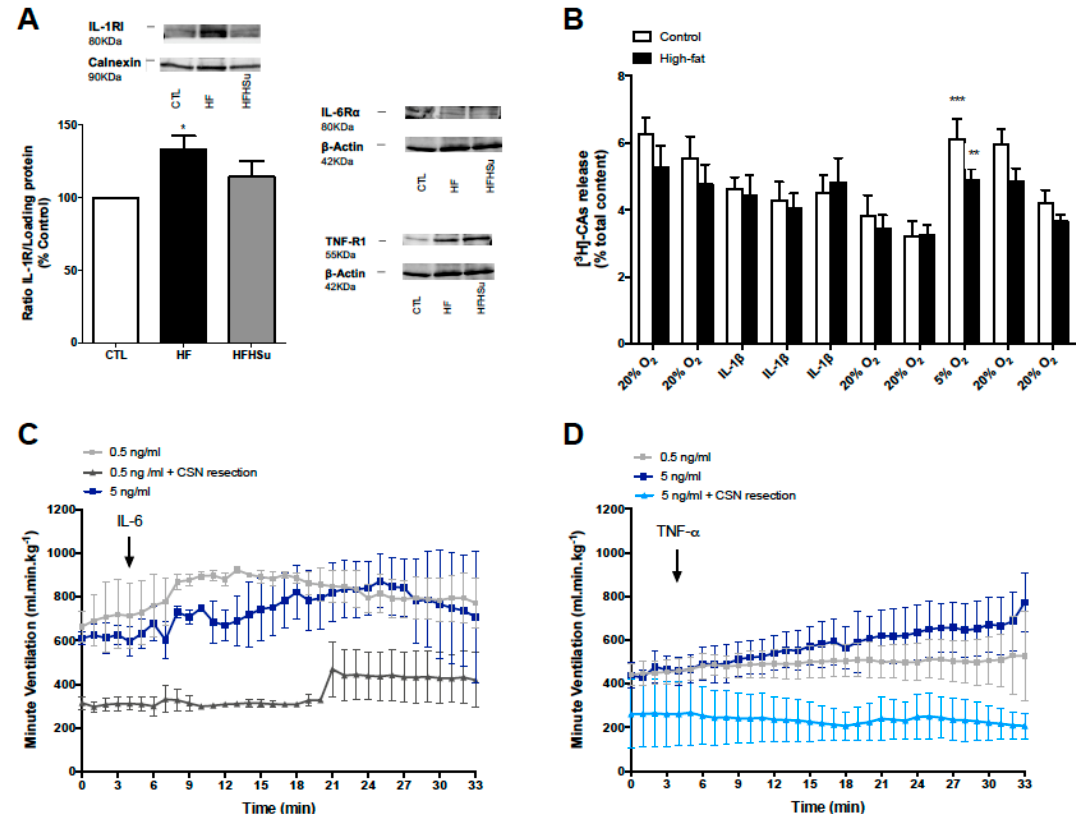
Figure 4. E ff ect of hypercaloric diets on the expression of pro-inflammatory cytokines receptors in CB and e ff ect of pro-inflammatory cytokines on ventilation and catecholamine release from the carotid body (CB). ( A ) E ff ect of high-fat (HF) for 3 weeks and high-fat high-sucrose (HFHSu) diet for 25 weeks on the expression of the receptors IL-1RI, IL-6R α , and TNF-R1 in rat CB. ( B ) E ff ect of interleukin-1 beta (IL-1 β , 40 ng / mL) on the release of catecholamines from the CB in control and HF animals. ( C , D ) E ff ect of interleukin-6 (IL-6, 0.5 or 5 ng / mL) and tumor necrosis factor alpha (TNF- α , 0.5 or 5 ng / mL) on basal ventilation, respectively, measured in anesthetized animals with pentobarbital (60 mg / kg.i.p.). TNF- α and IL-6 were administrated in the femoral vein, as described previously